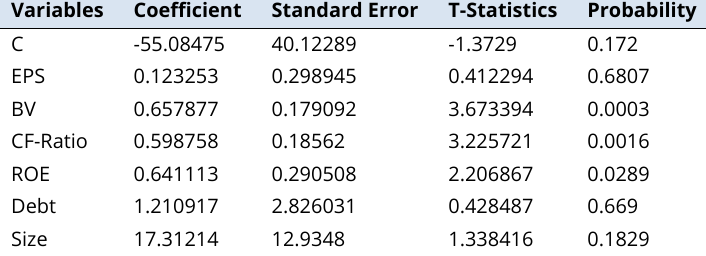
Fixed Effect Model of IFRS Transition Period -2009 to